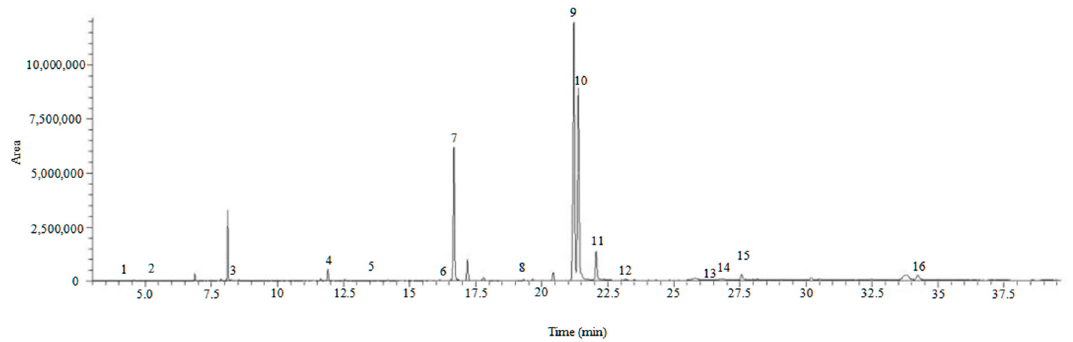
Figure 3. GC-MS chromatogram of fatty acids in Gonostegia hirta : 1. Octanoic acid; 2. Decanoic acid; 3. Lauric acid; 4. Myristic acid; 5. Pentadecanoic acid; 6. Palmitoleic acid; 7. Palmitic acid; 8. Heptadecanoic acid; 9. Linoleic acid; 10. Inolenic acid; 11. Stearic acid; 12. Stearolic acid; 13. Nonadecanoic